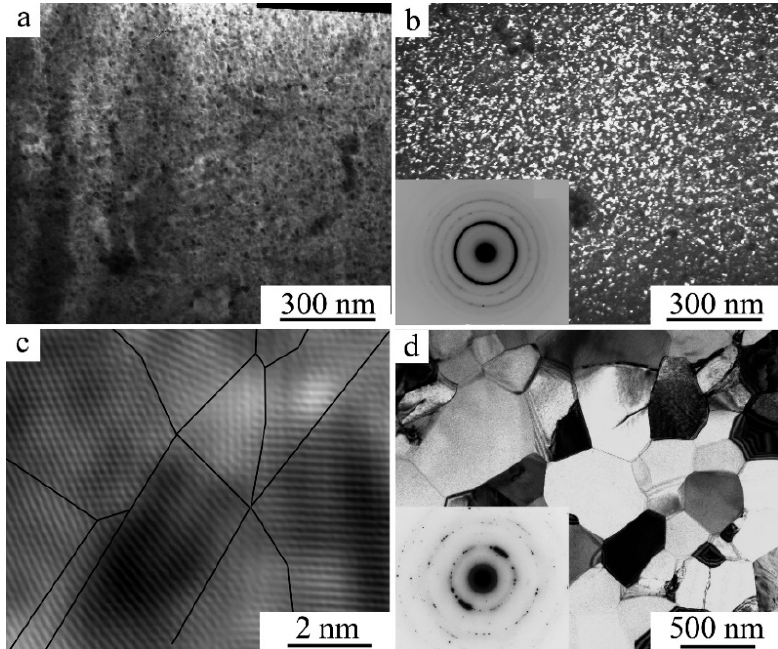
Figure 14. TEM images of alloy ( a – c ) Ti 49.4 Ni 50.6 after high-pressure torsion (HPT), 5 revs, at 7 GPa, and subsequent annealing 523 K, 20 min and ( d ) Ti 49.8 Ni 50.2 after step equal-channel angular pressing (ECAP) at 773 K + 723 K + 673 K, six passes.